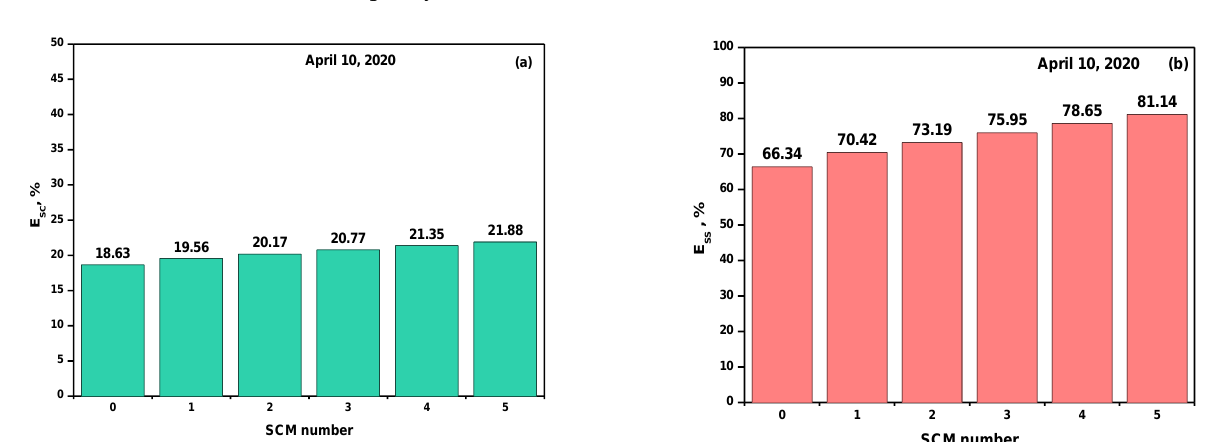
Figure 9. E SC percentage ( a ) and E SS percentage ( b ) for the sunny day of 10 April 2020.